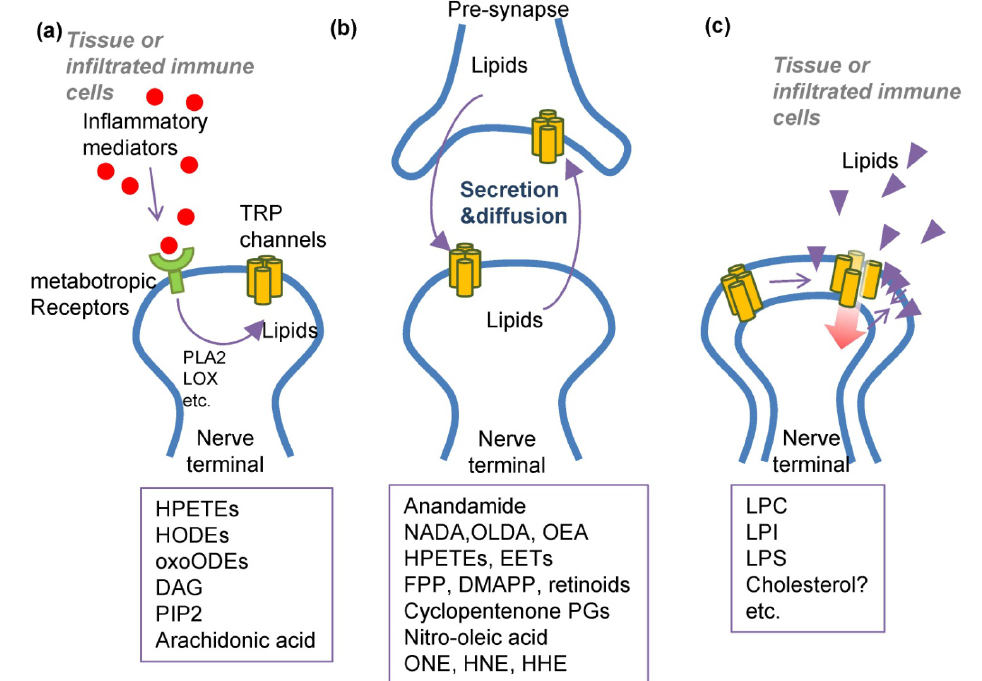
Figure 2. Three possible modes of interactions of TRP channels and their lipid